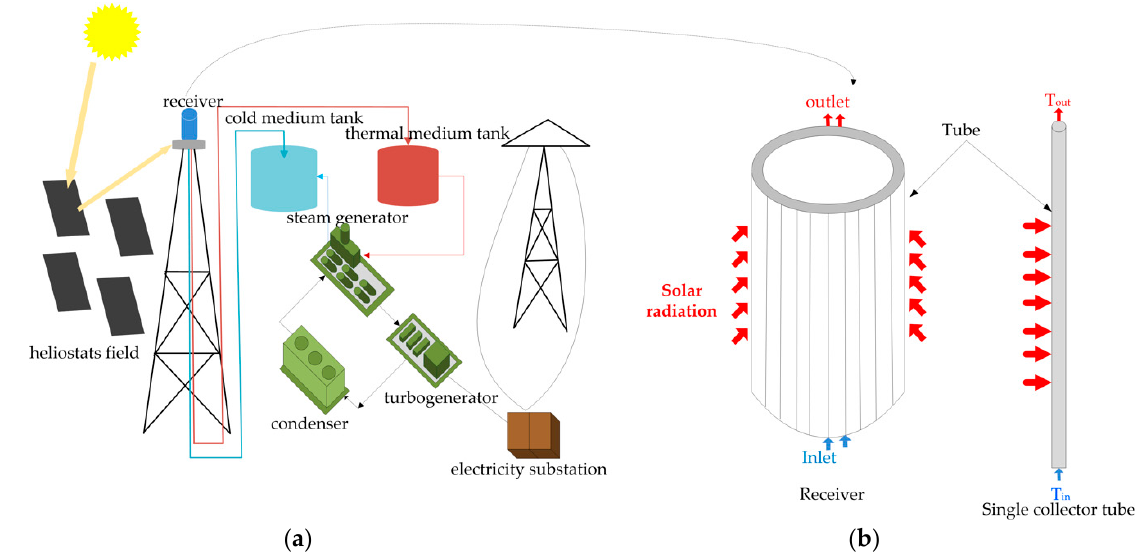
Figure 1. ( a ) Solar power tower system; ( b ) Exposed cylindrical heat receiver and a single receiver tube